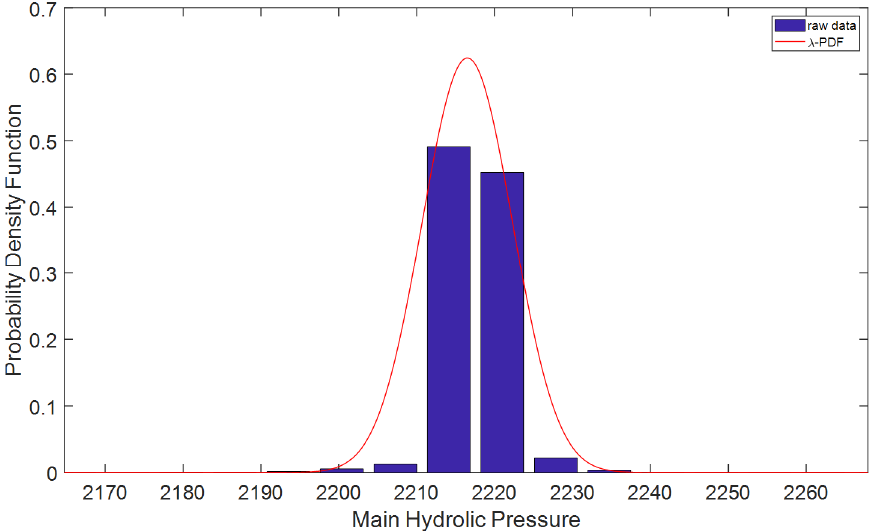
Figure 4. PDF of the main hydraulic pressure.